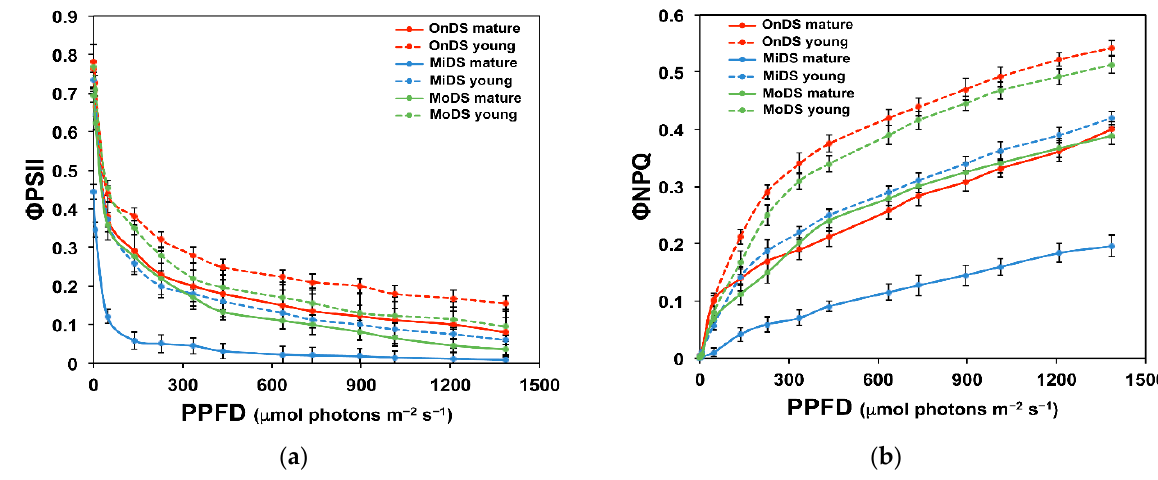
Figure 3. Light response curves of the effective quantum yield of photochemistry ( Φ PSII ) ( a ) and of the regulated energy dissipated in PSII ( Φ NPQ ) ( b ), in A. thaliana young and mature leaves, at the onset of drought stress (OnDS), at mild drought stress (MiDS) and at moderate drought stress (MoDS). Error bars represent ± standard error of the mean (n = 5–6).